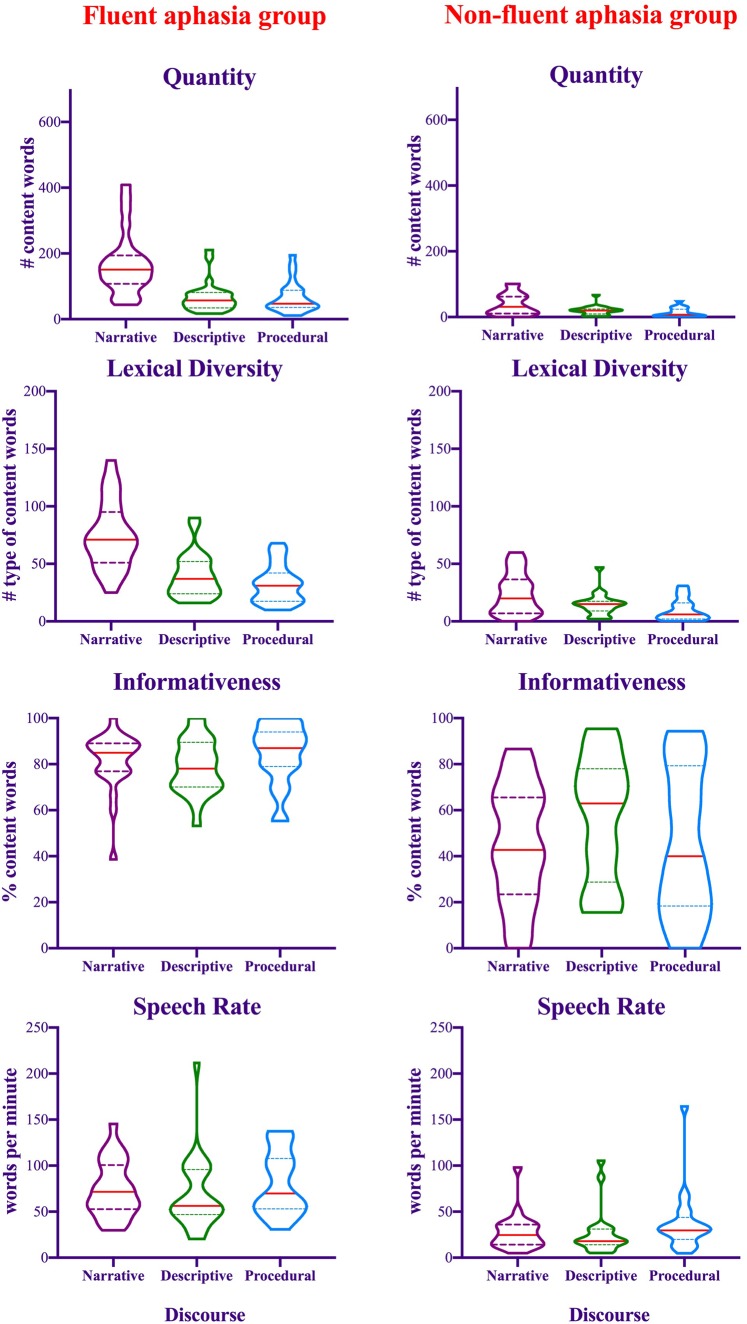

Violin plots showing the distribution of the data and the probability density of four connected speech measures produced during three discourse genres among both fluent and non-fluent aphasia groups. Straight red lines refer to the group median, top dotted lines refer to the third quartile, and bottom dotted lines refer to the first quartile.